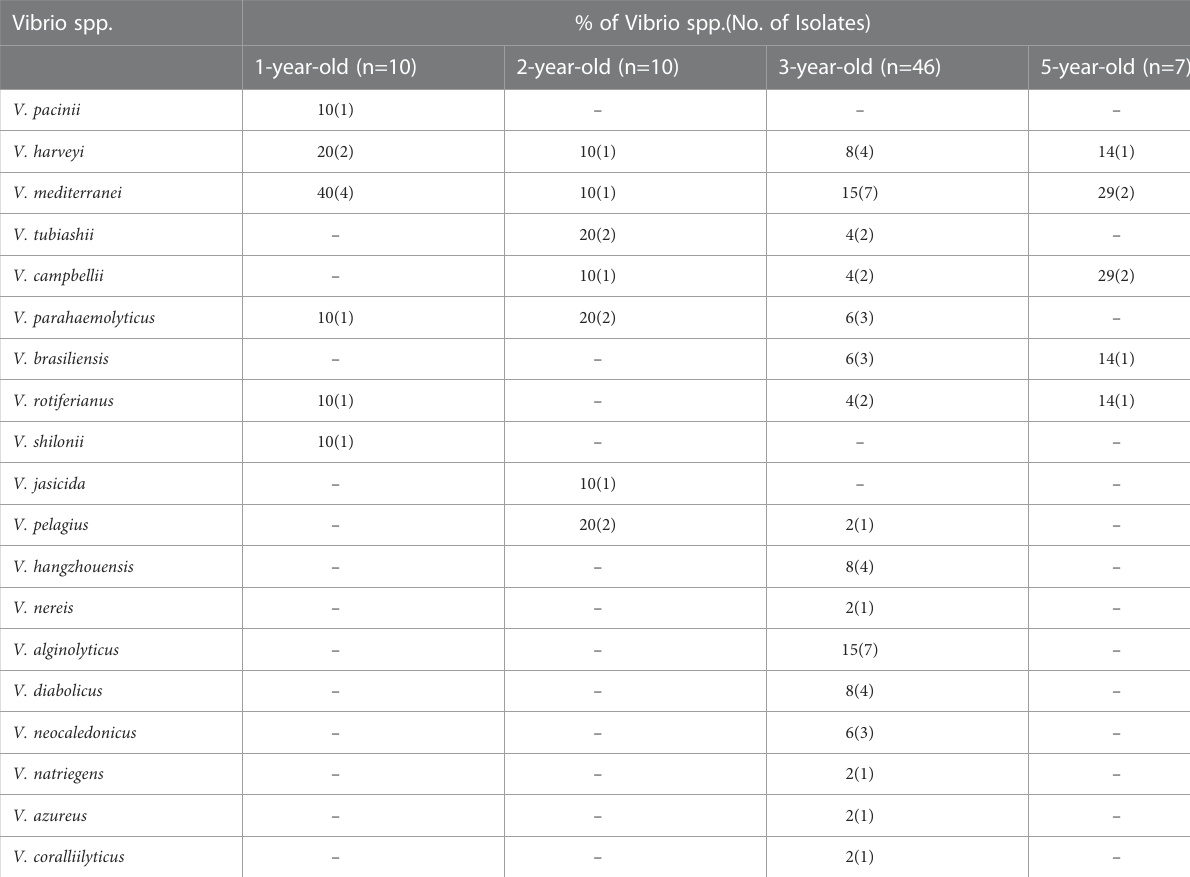
TABLE 1 Vibrio spp. of clams in different ages. Vibrio